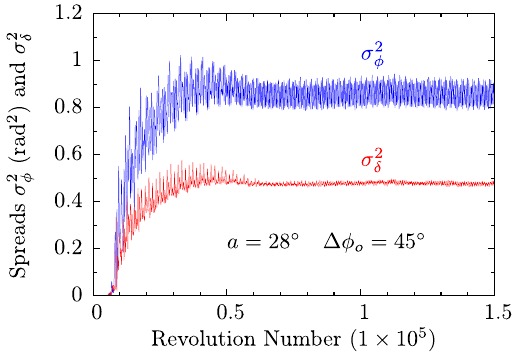
FIG. 20. Longitudinal bunch sizes as functions of revolution ¼ 28 ° and Δ ϕ ¼ 45 ° as the diffusion process number for a m o evolves and equilibrates after about 6 . 5 × 10 4 revolutions.